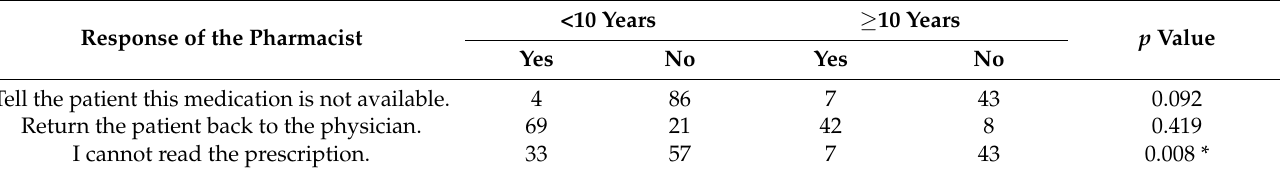
Table 2. Comparison between the experience of the pharmacists and the response of the pharmacist. Response of the